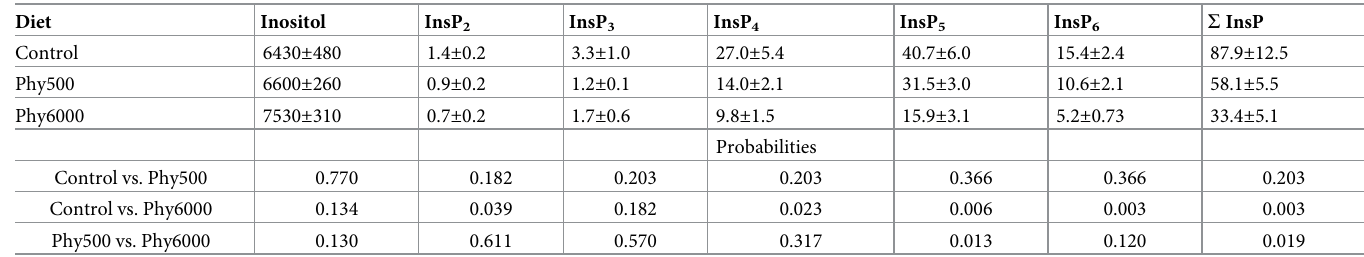
Table 5. Inositol and inositol phosphate (InsP 2-6 ) levels (nmol/g wwt) in kidney of day 21 broilers 1,2 .